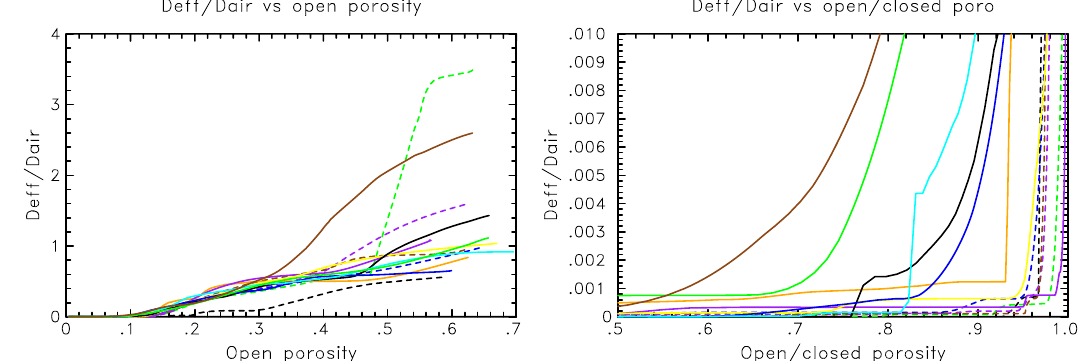
Fig. 11. Comparison of the diffusivity profiles (reduced to CO 2 ) calculated for the 13 drill holes considered. Deff/Dair is the ratio of firn diffusivity to the diffusion coefficient of CO 2 in free air. The left panel emphasises the upper firn, whereas the right panel emphasises deep firn. Arctic sites are shown with dashed lines: Devon Island in black, Summit in blue, NEEM-EU in purple and NEEM-US in brown, North GRIP in green. Antarctic sites are shown as continuous lines: DE08 in orange, Berkner in purple, Siple in yellow, South Pole 1995 in dark blue, South Pole 2001 in light blue, Dronning Maud Land in black, Dome C in green and Vostok in